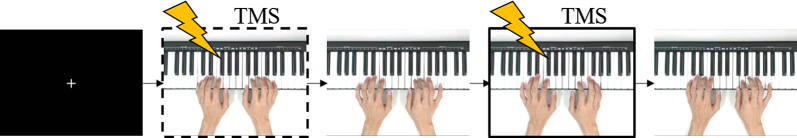
The sequence of stills from the video clip used in the motor imagery (MI) task. The frame in the dashed box is at the timing of striking a C note and the frame in the solid box is at the timing of striking a G note. During the first 150 frames, a white cross in the center of a black screen was presented. Following the action being displayed, a C note was struck at 155, 335, 635, and 880 frames (of 890 in total) after action onset (after the white cross disappears). After 506/890 frames of the action onset, a G note was struck. TMS was delivered at one of these five-time points. TMS, transcranial magnetic stimulation.